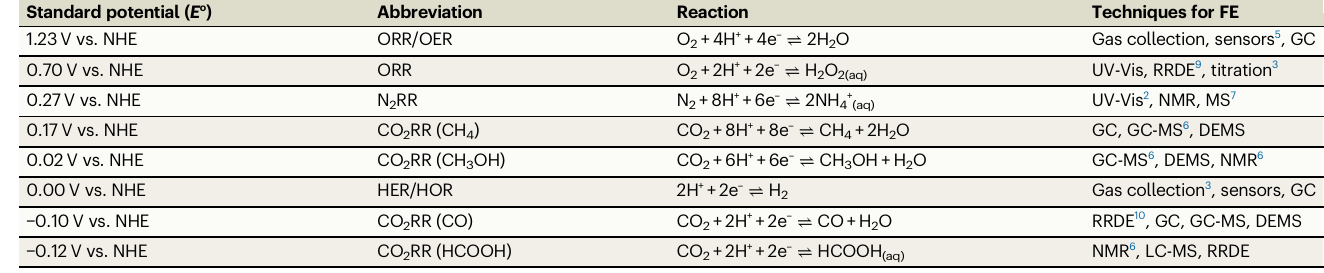
Table 1 | Standard potentials versus the normal hydrogen electrode (NHE), reactions, and commonly employed FE mea- surement techniques for the proton-coupled reactions discussed in this Comment